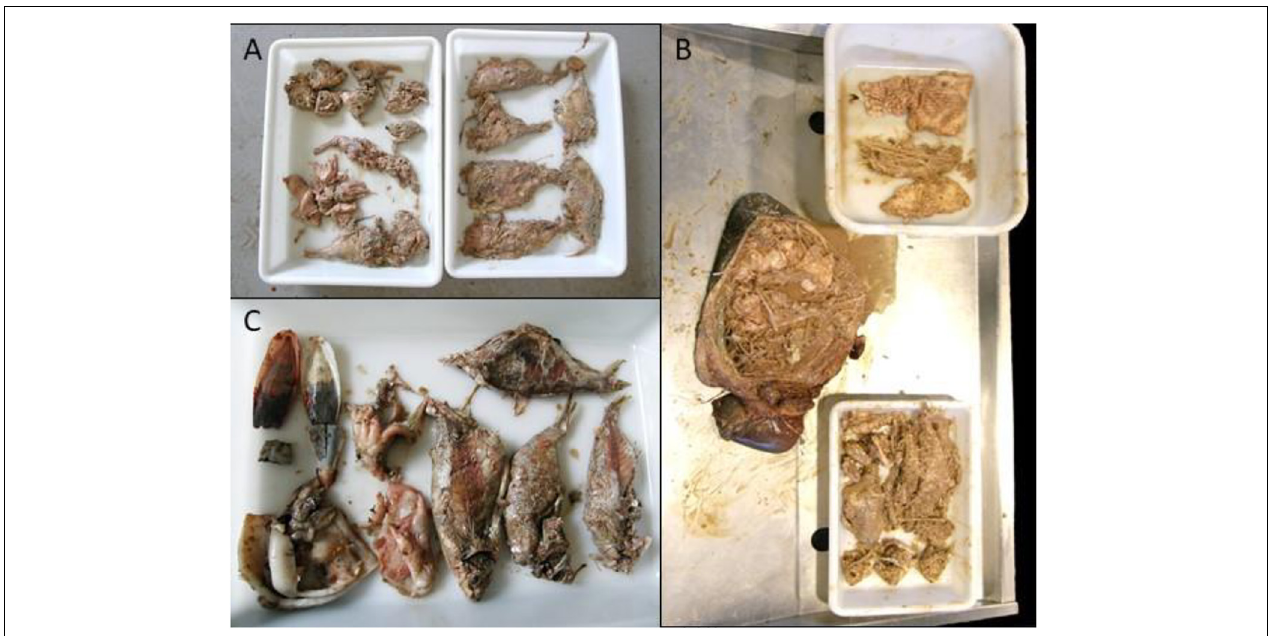
FIGURE 2 | Gastric contents in case 9 (A) , case 8 (B) and case 5 (C)